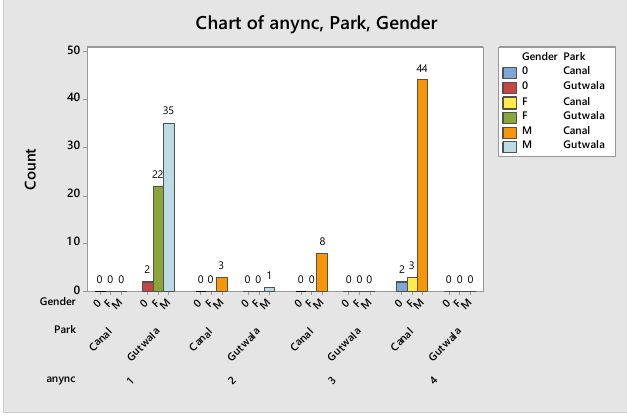
Figure 17: Bar Chart of annoyance between both sites 44 male and 3 female out of 60 visitors responded highly affected by the annoyance problem due to noise pollution by the fig.16 while 8 male out of 60 showed mild , 3 male out of 60 showed low and 2 out of 60 did not show any response in the site-1 Canal Park, Contrarily, all sampled 60 visitors including both male and female except 2 visitors in the Site-2 Gat Wala Park did not show any symptom of Annoyance due to noise pollution, which mean the mostly response observed in this regard was nil (Annoyance).